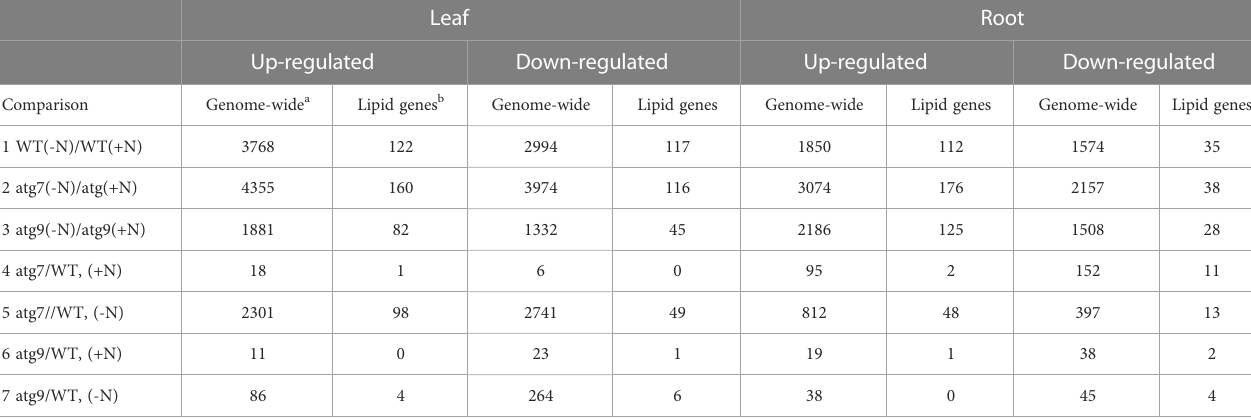
TABLE 1 Number of differentially expressed genes in leaves and roots of WT, and atg7 and atg9 mutants grown in normal (+N) or autophagy-inducing (-N) conditions.